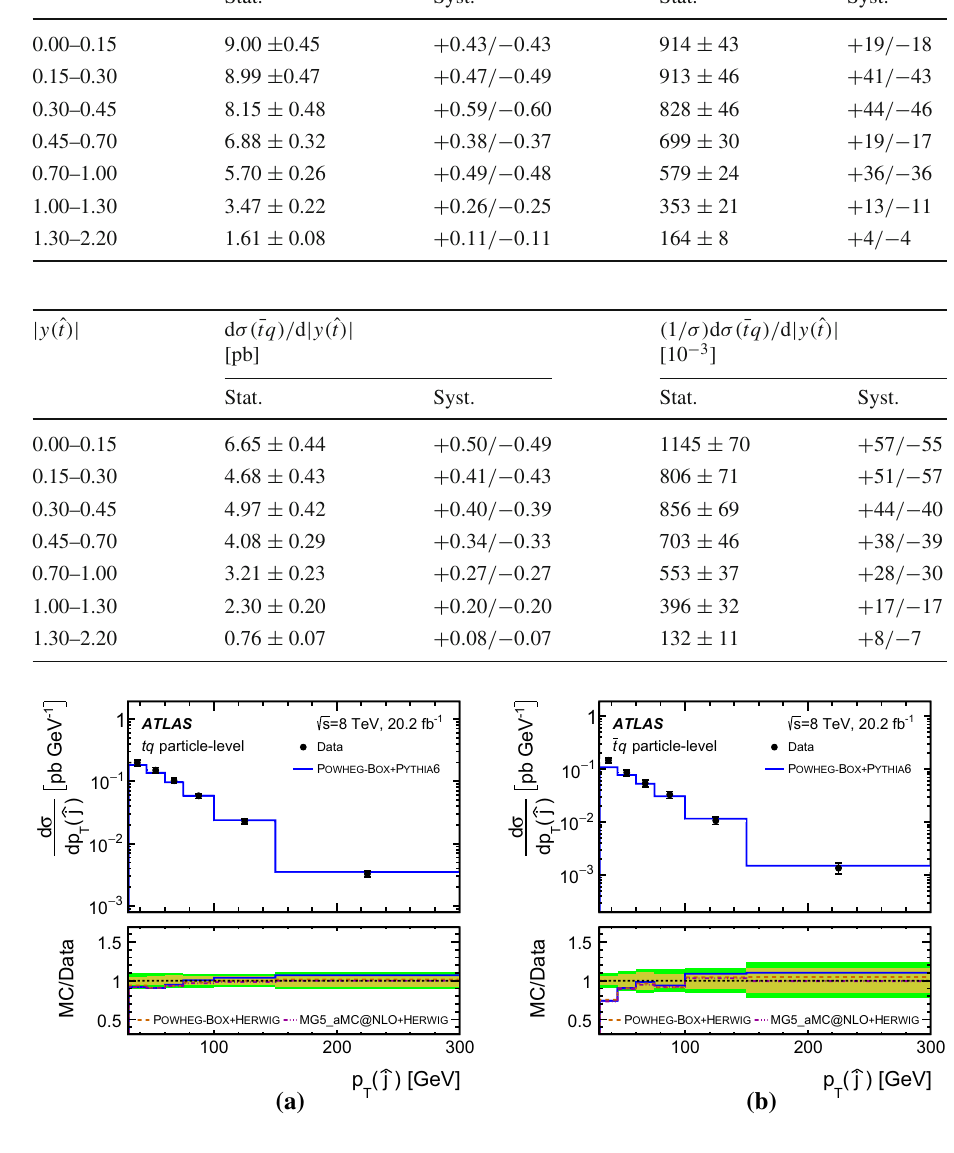
normalised unfolded differential tq production cross-section as a function of | y ( ˆ t ) | at particle